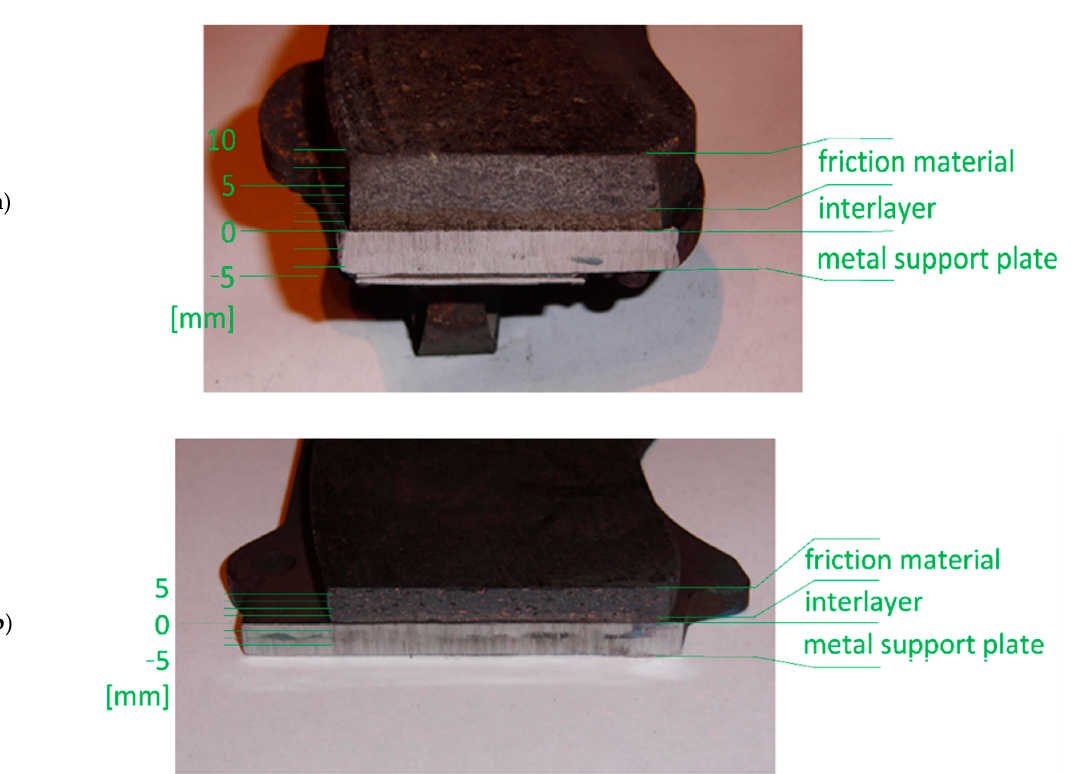
Figure 2. Cross-sections of brake pads used in the tests: ( a ) first group and ( b ) third group.